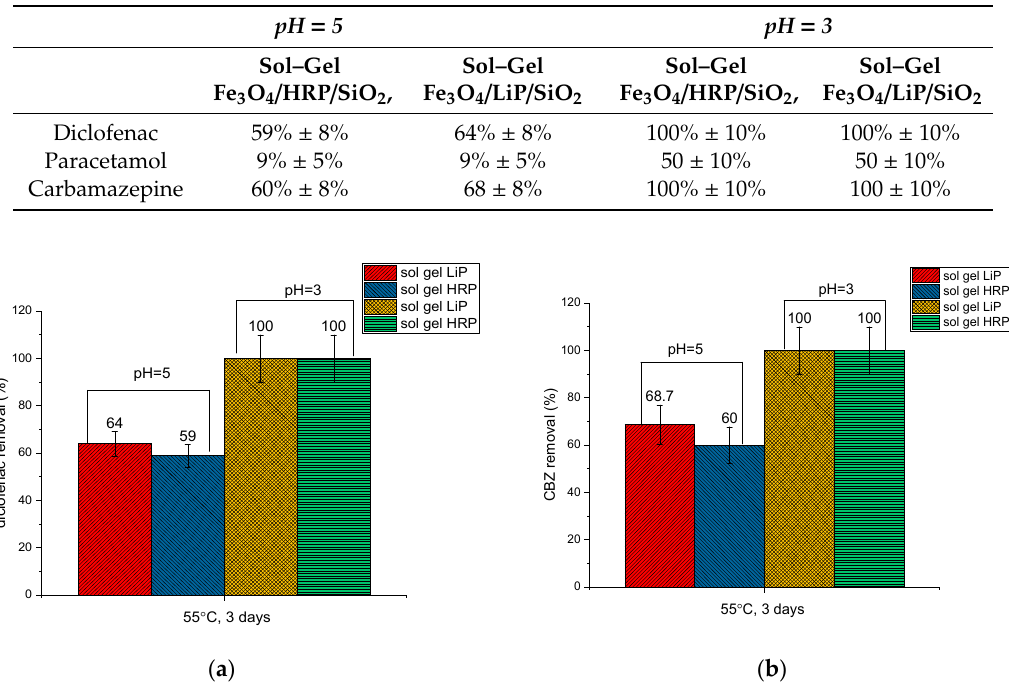
Figure 10. ( a ) Diclofenac removal at pH 5.0 and pH 3.0. ( b ) CBZ removal at pH 5.0 and pH 3.0.